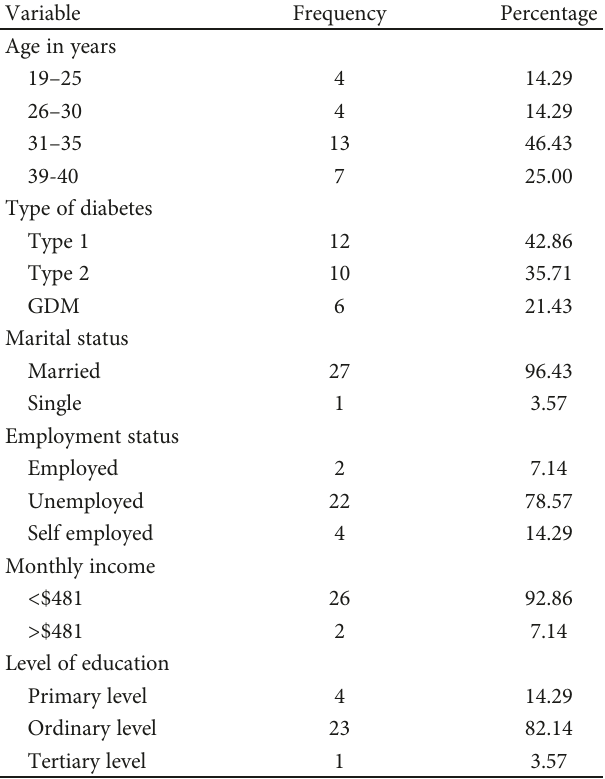
Table 1: Summary of demographic characteristics for participants for FGDs ( N = 28 ).